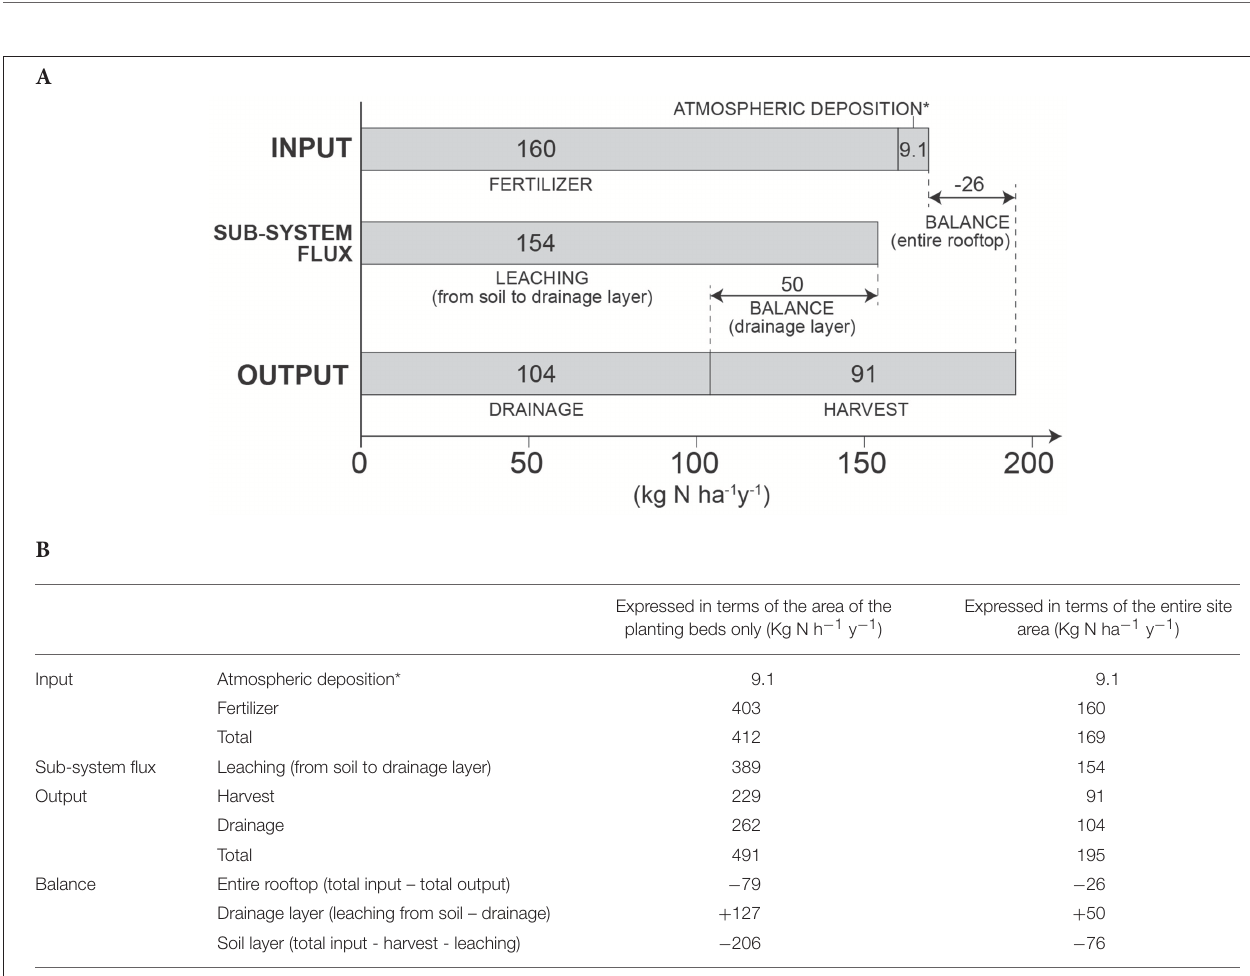
FIGURE 4 | Annual N balance of the Brooklyn Grange Navy Yard farm, NYC, between 11/12/2015 and 11/12/2016. The top figure (A) compares N fluxes expressed in terms of the entire site area. *Bulk collector 1.5m above the soil surface. The bottom figure (B) shows each flux expressed both in terms of the area of the planting beds only, and in terms of the entire site